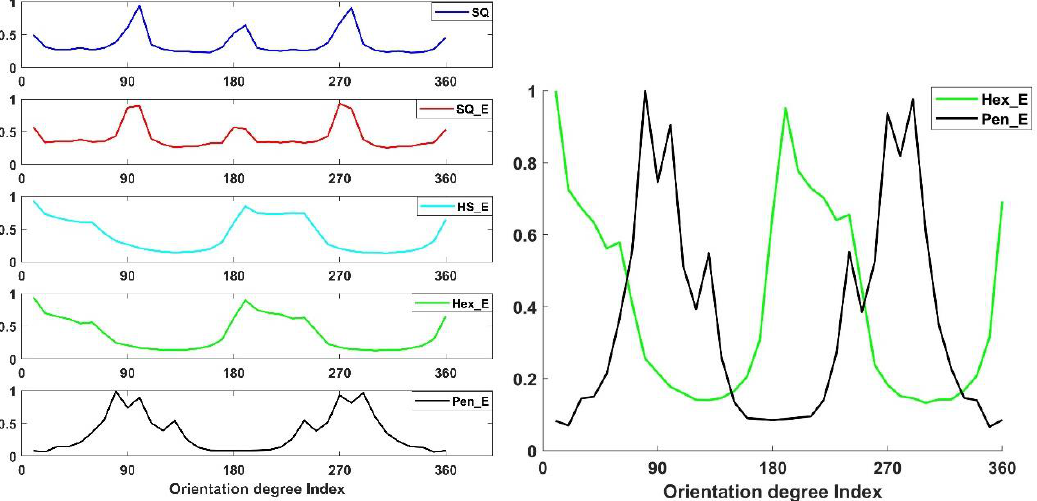
Figure 10. The histograms of the gradient orientation with 36 bins are shown in the ( left ). From top to bottom, there are results related to SQ, SQ_E, HS_E, Hex_E and Pen_E respectively. The ANCHORs show the average values of 23 histograms of the gradient orientation. The ( right ) shows the comparison between ANCHORs of Pen_E (black) and Hex_E (green). These ANCHORs together, representing combination of two types of sensor arrangements, compensate each other’s week sensitivity areas and become more sensitive to detect directional changes of intensities.